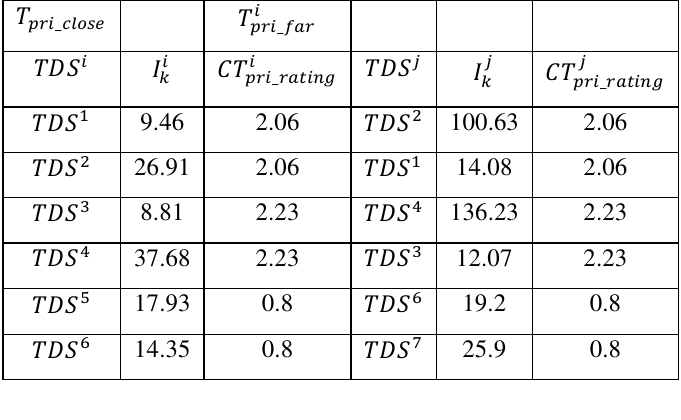
Table 5: VALUES FOR CURRENT TRANSFORMER AND